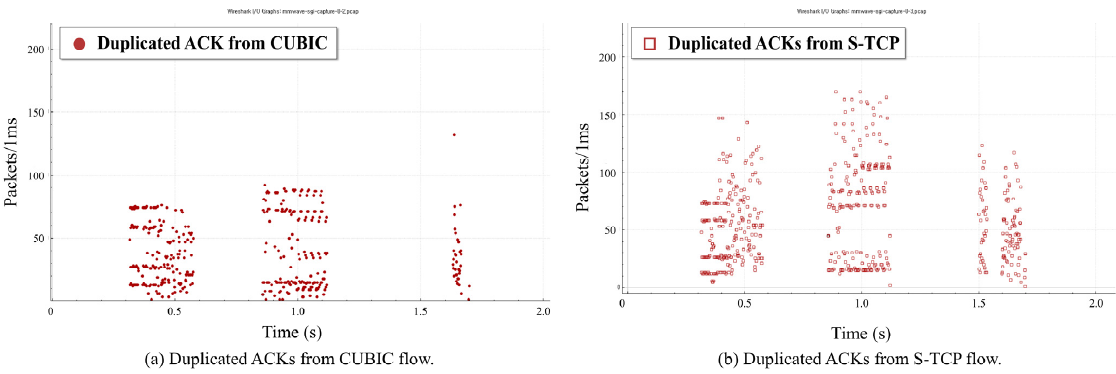
Figure 5. Duplicated ACKs generated during the slowstart phase: ( a ) CUBIC flow; ( b ) S-TCP flow.